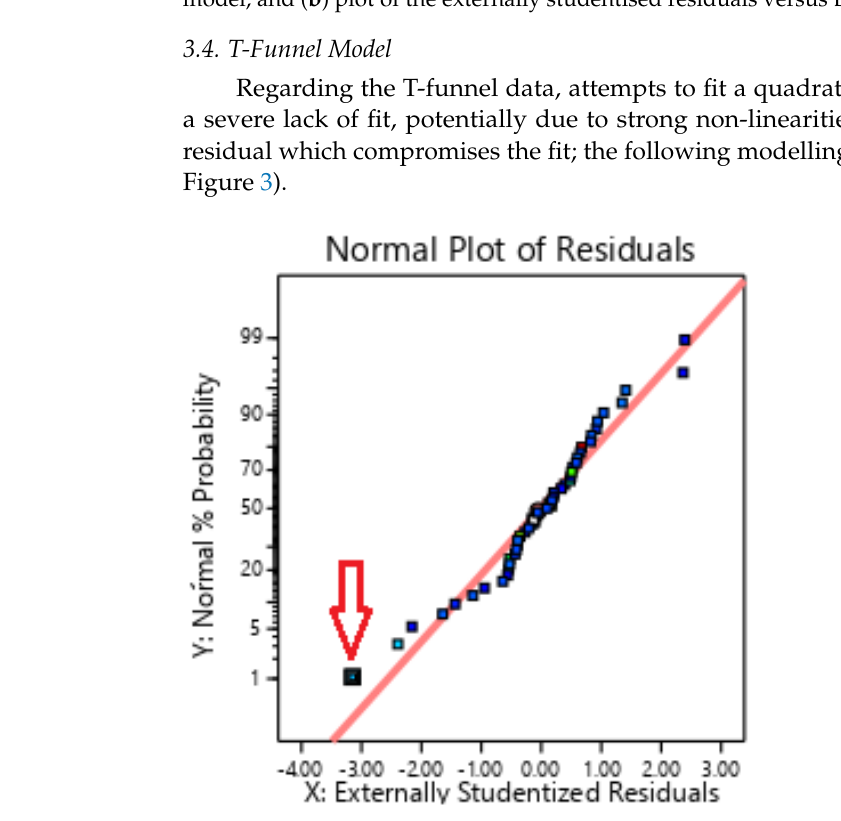
Figure 3. T-funnel results: F15 excluded (arrow).